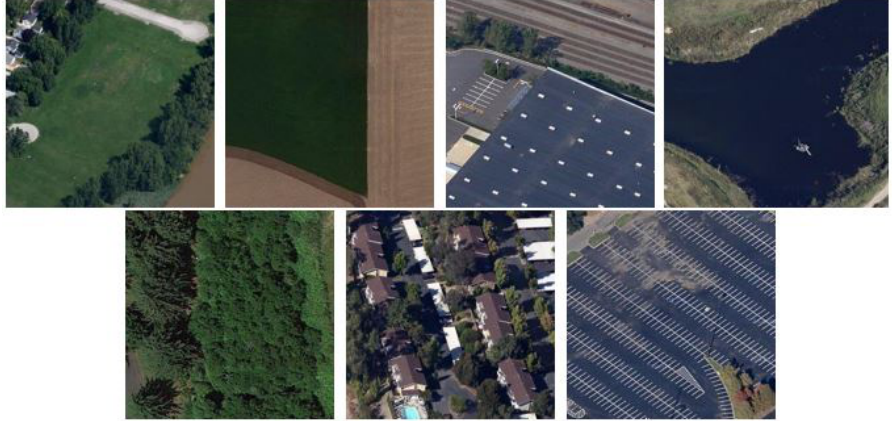
Figure 8. Class representatives from the RSSCN image dataset